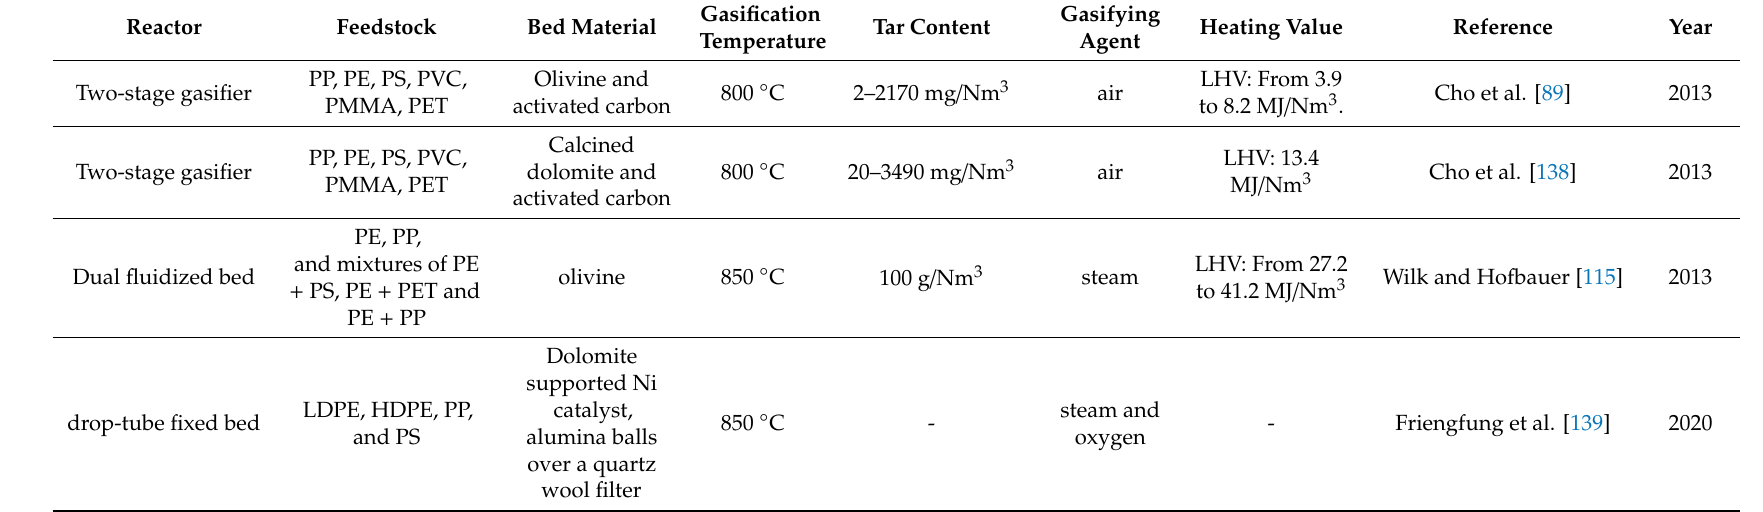
Table 5. Plastics mix gasification summary